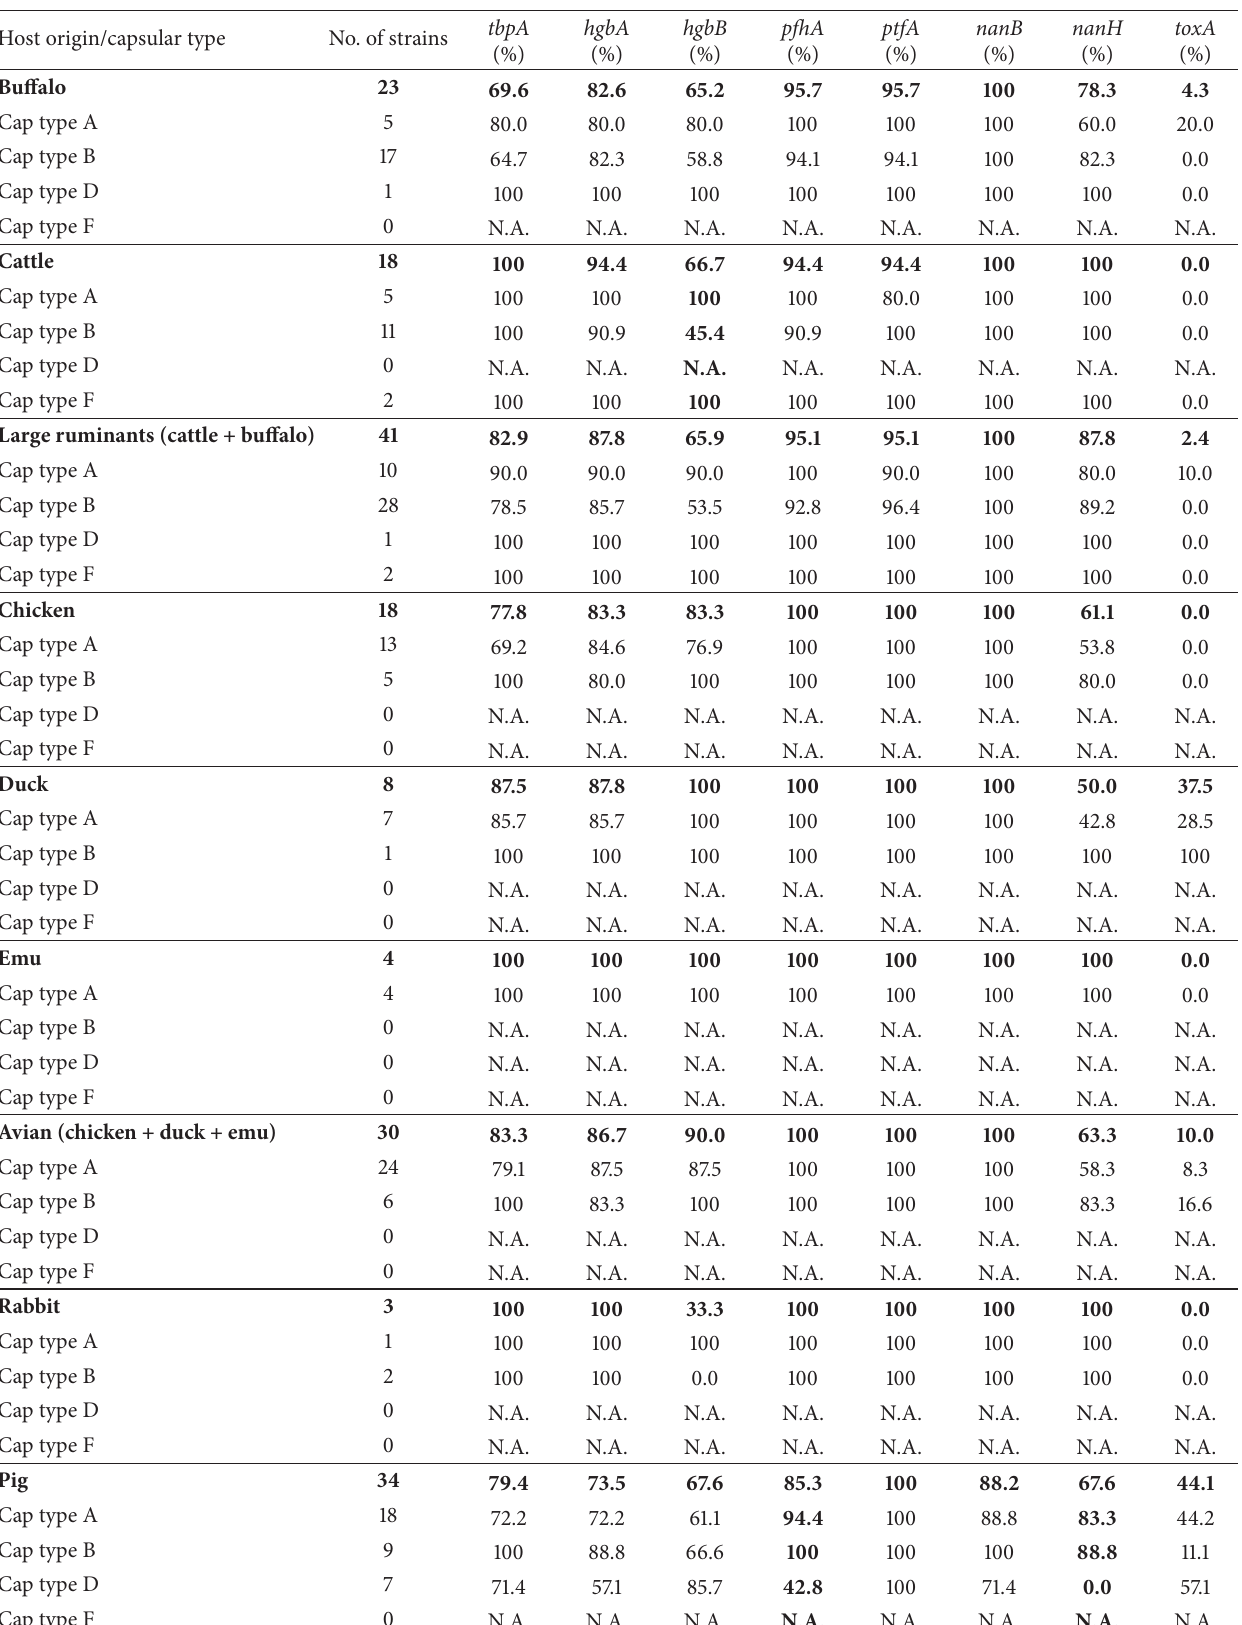
Table 3: Prevalence of virulence associated genes among Pasteurella multocida isolates recovered from various host species of India. Host origin/capsular type